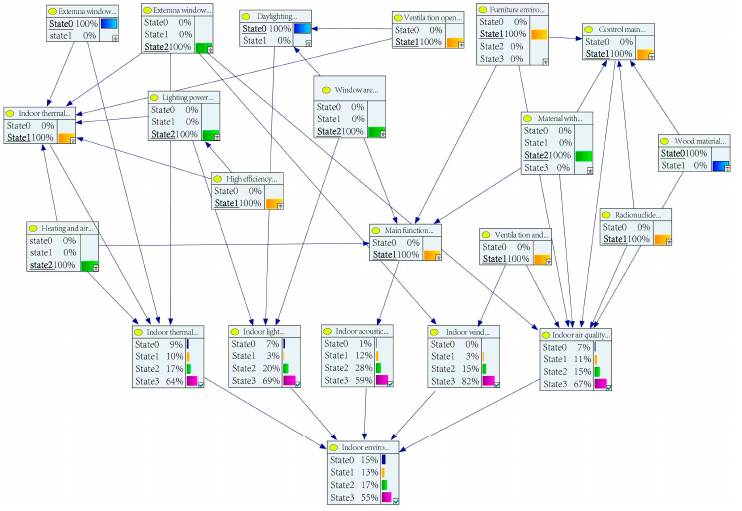
Figure 10. Indoor environmental quality evaluation model of a decoration project in